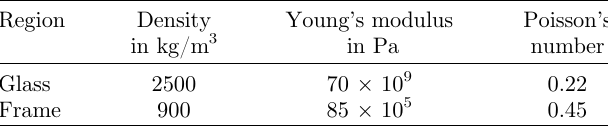
Table 1. Material properties of structural mechanics regions.